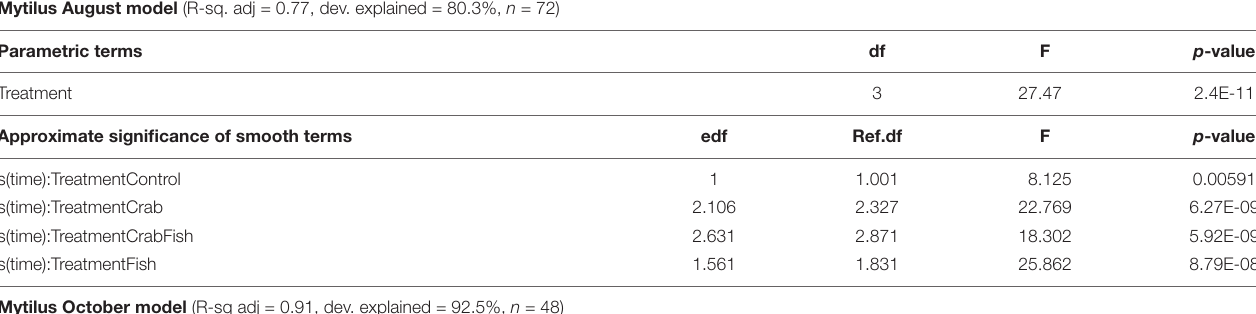
TABLE 1 | Summary of the three GAMs performance; i.e., R-square adjusted and explained deviance, and the results of the Wald test of each model. Mytilus August model (R-sq. adj = 0.77, dev. explained = 80.3%, n =